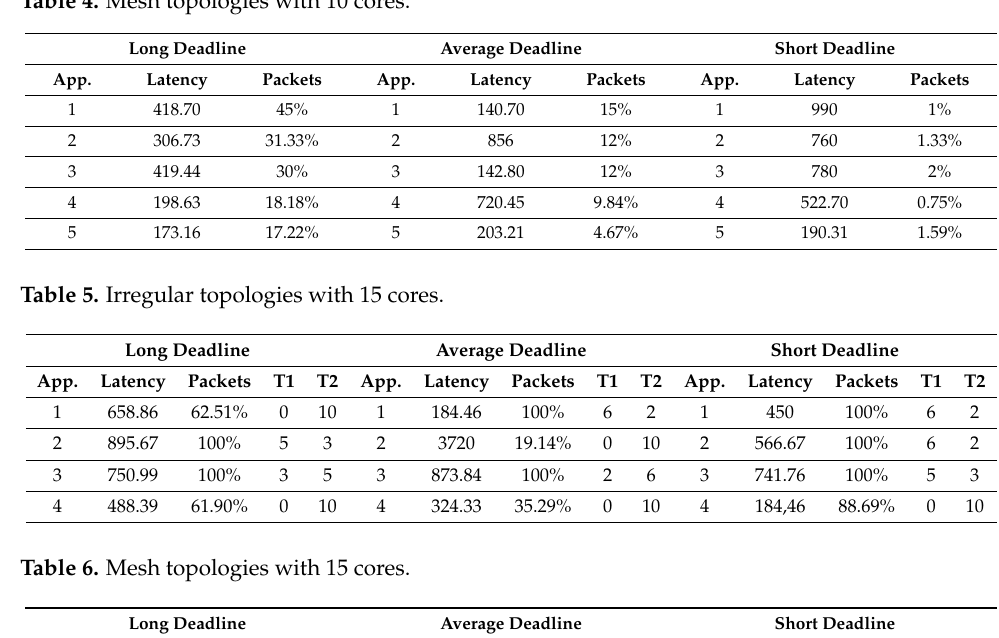
Table 4. Mesh topologies with 10 cores.